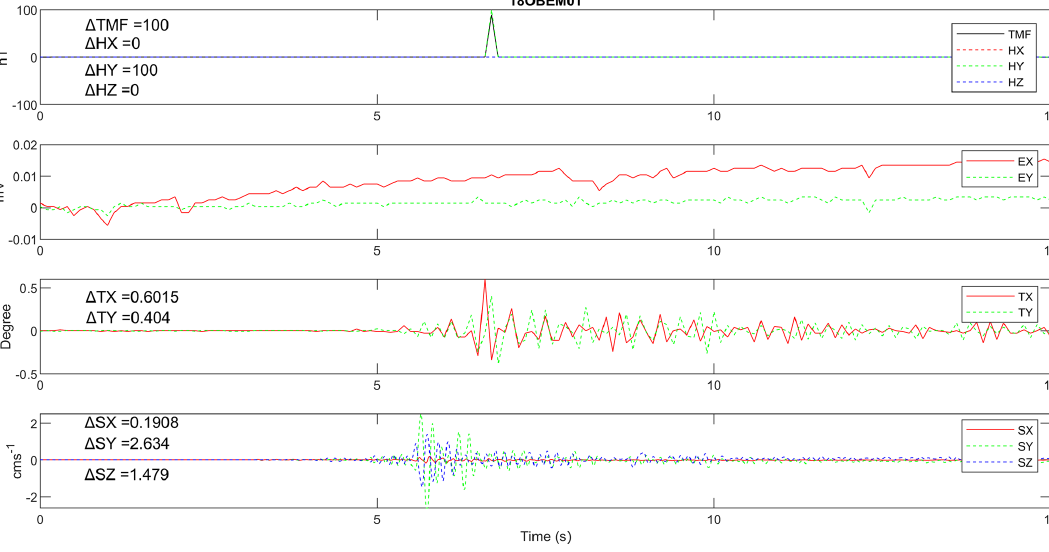
Figure 14. The variations in PGV, TMF, HY, TX and TY during the first earthquake. The PGV of 2.63cms − 1 affected the inclinations by 0.601 and 0.404 ◦ for TX and TY, respectively, and the HY magnetic field had a peak of 100nT. SH1 and SH2: two horizontal components of the seismic signal; SZ: vertical component of the seismic